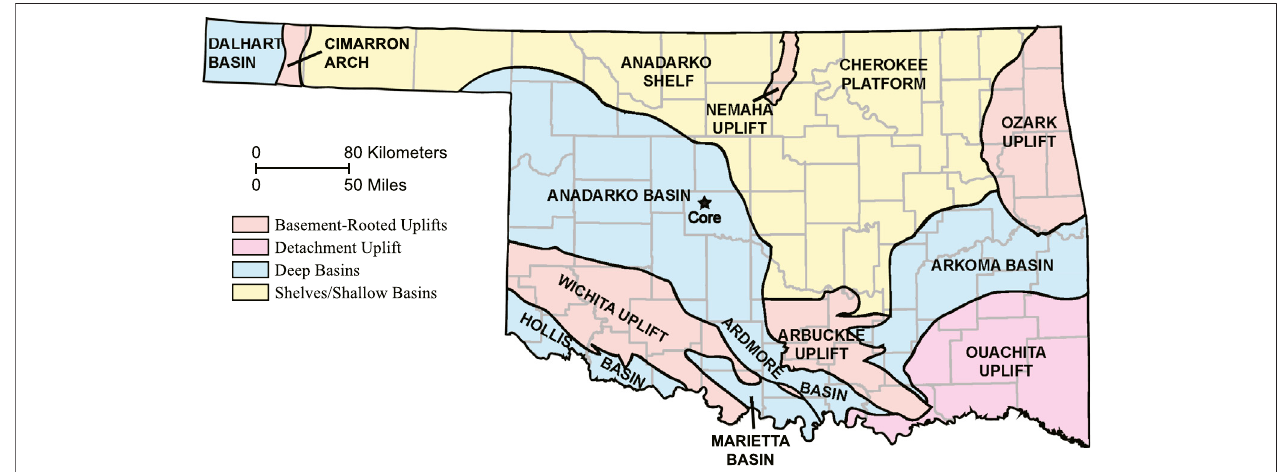
FIGURE 1 | Base Map. Major geological features and county lines within the state boundary of Oklahoma are labeled (after Northcutt and Campbell, 1996). Solid star is the core location in Canadian County.